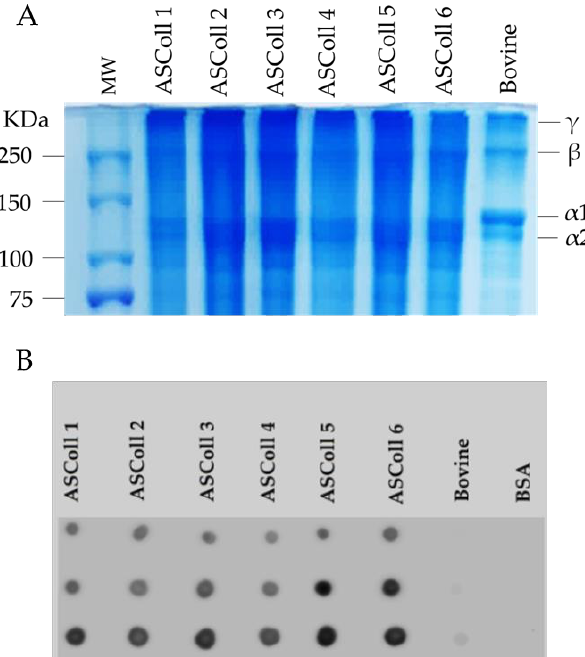
Figure 1. Molecular profile of ASColl. ( A )—Electrophoresis profile from the ASColl samples and type I collagen from bovine skin. MW—molecular weight standard protein marker. ( B )—Dot blot analysis of the ASColl samples and type I collagen from bovine skin. BSA—Bovine serum albumin; bovine—type I collagen from bovine skin.